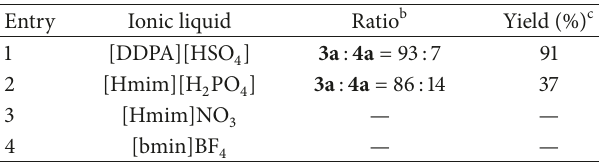
Table 1: Model of Hantzsch reaction directly from benzyl alcohol in different ionic liquids a